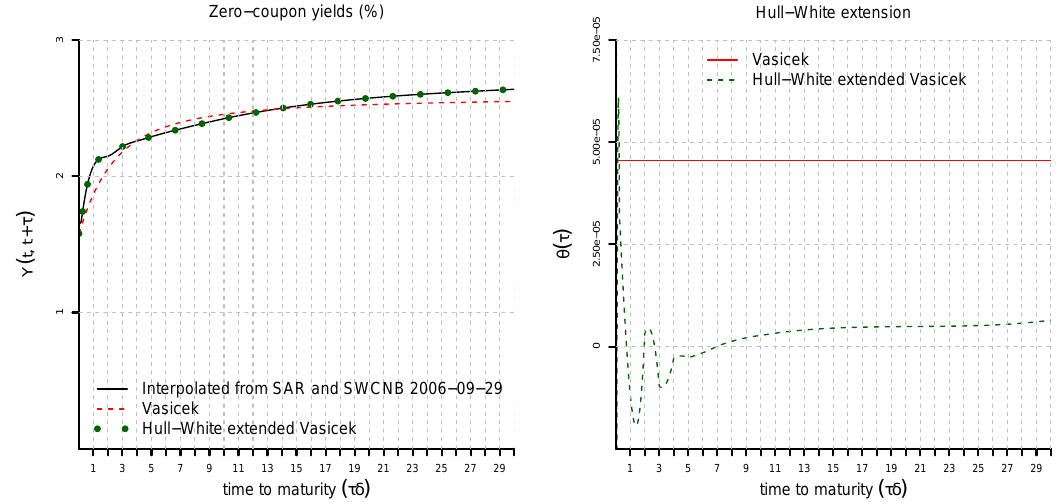
Figure 15. Three-factor Hull–White extended Vasiˇcek yield curve (lhs) and Hull–White extension θ (rhs) as of 29 September 2006. The parameters are estimated as in Figures 11–13. The initial factors are obtained from the Kalman filter for the estimated parameters. The calibration of the Hull–White extension requires yields on a time to maturity grid of size ∆ . These are interpolated from SAR and SWCNB using cubic